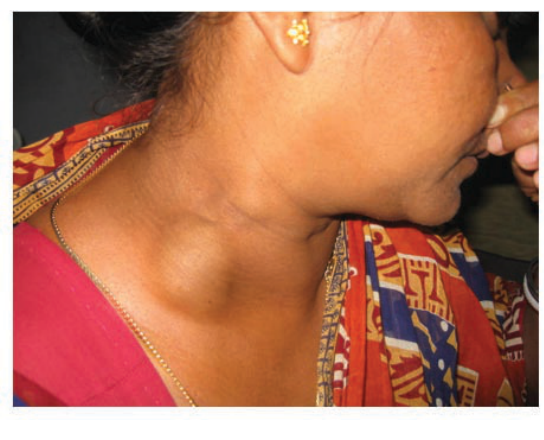
Figure 2. Increase in size of the aneurysm with the valsalva